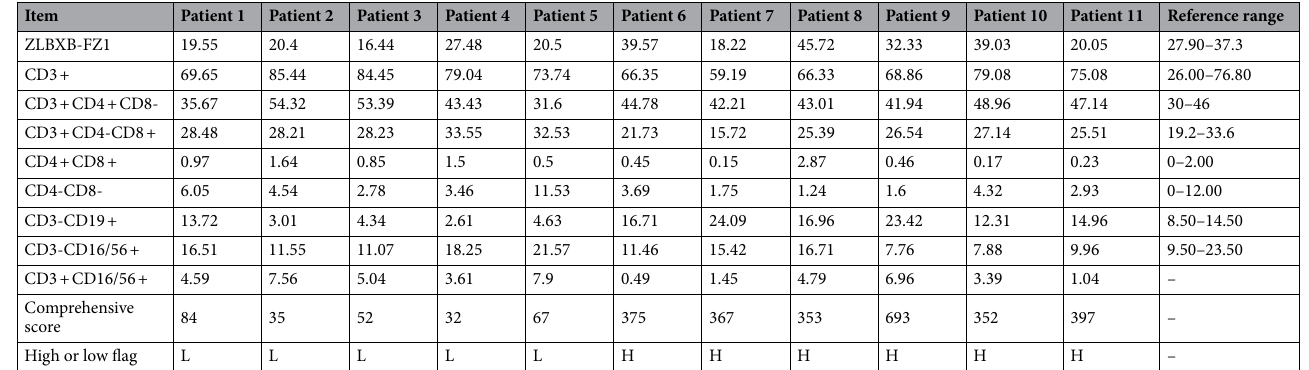
Table 1. Results and groups of host quality of immune